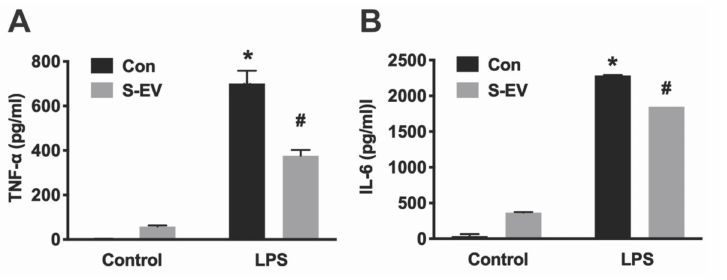
Figure 5. Primary microglia were pre-incubated with S-EVs for 24 h and then treated with LPS for 24 h. Culture supernatant was collected to determine cytokine [TNF- α ( A ) and IL-6 ( B )] expression by ELISA. Data represented three independent experiments and was analyzed by ANOVA. * p < 0.05 versus control. # p < 0.05 versus non